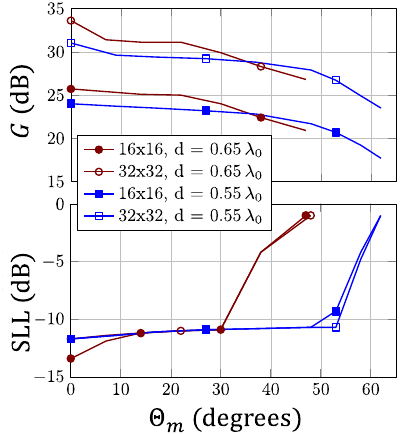
Figure 34. Antenna gain G and side lobe level (SLL) versus main beam direction Θ m of a 16 × 16 and 32 × 32 array of the proposed topology with two spacings— d = 0.65 λ 0 and d = 0.55 λ 0 —between the radiating elements at 17.5 GHz [175]. Reprinted from [2], Cambridge University Press, 2020.